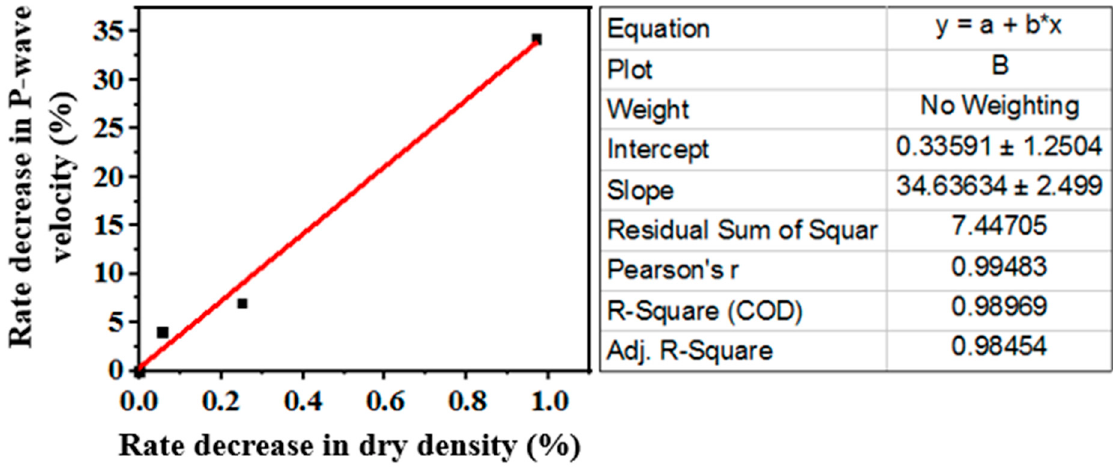
Figure 15. Correlation between rate decrease in dry density and rate decrease in P-wave velocity of the studied microschist at high temperature.